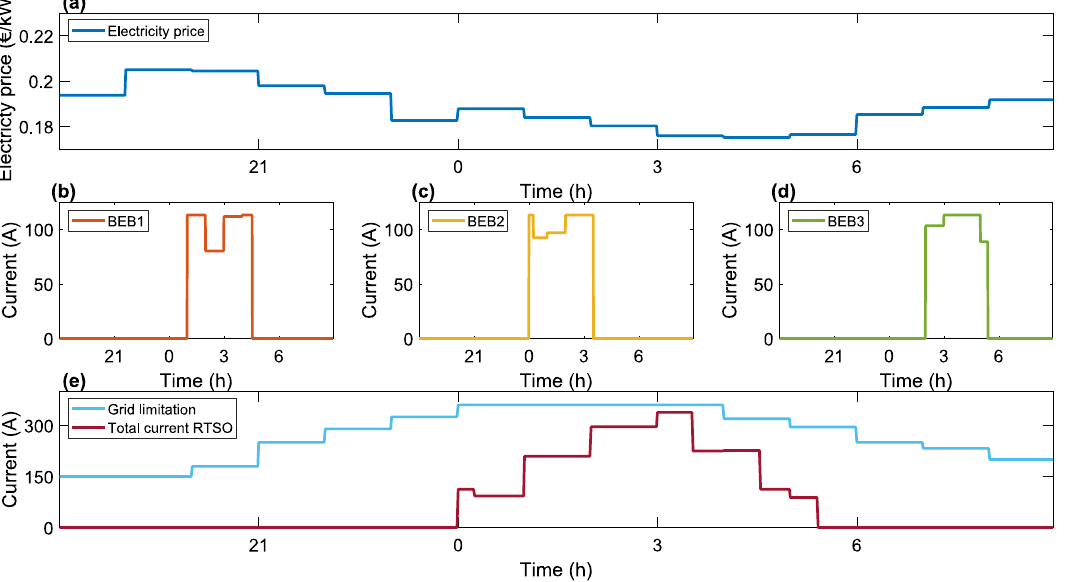
Figure 4. Simulation results of three BEBs charging overnight with ( a ) electricity tariff, ( b – d ) charg- ing current of each BEB and ( e ) total charging current and grid